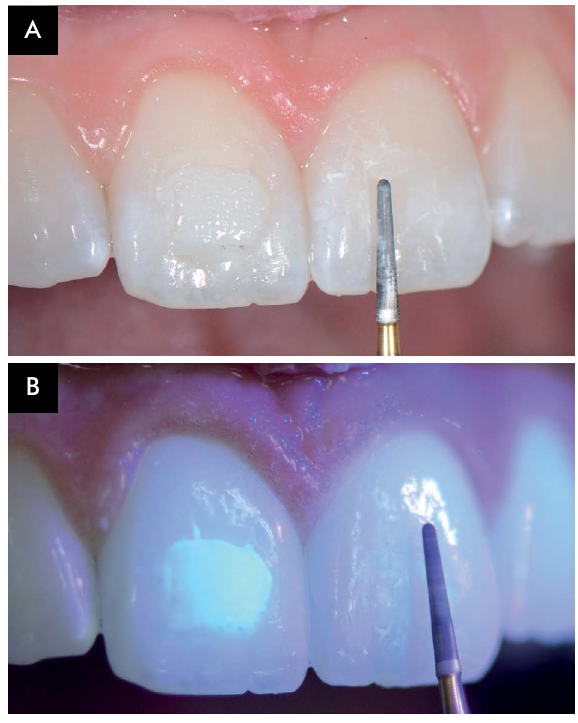
Figure 1. Methods tested for the removal of AR: a) No light (NL), multi-bladed 30-blade tungsten carbide bur coupled to a high-speed pen and reflector light; b) With light (WL), multi- bladed 30-blade tungsten carbide bur coupled to a high-speed pen using the UV light auxiliary illumination